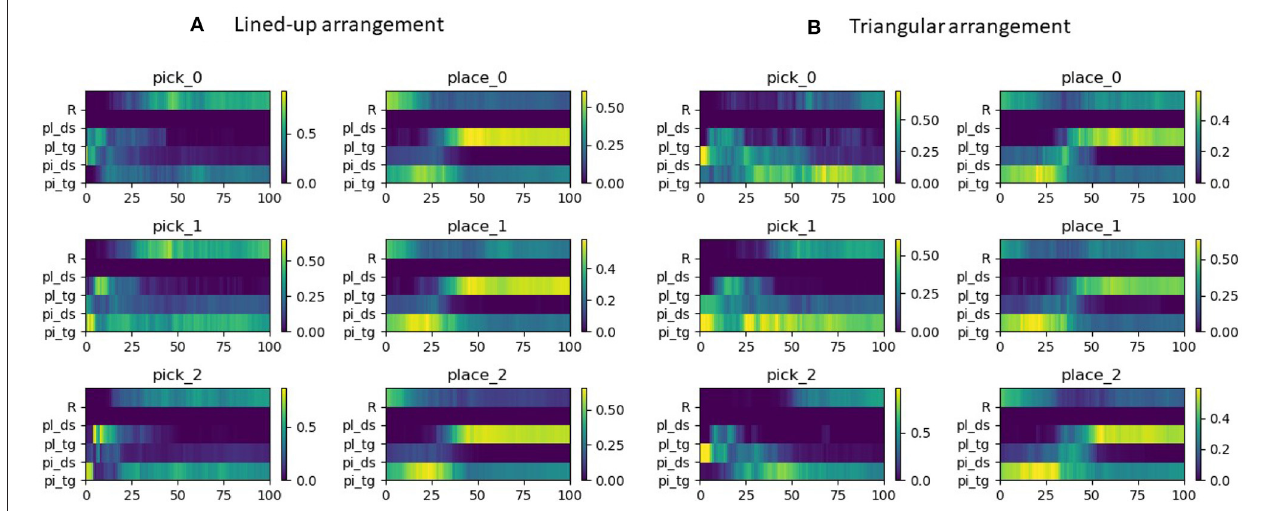
FIGURE 6 | Gaze distribution on a normalized time axis across semantic AoIs. Time = 0 signifies starting of the trial and time = 100 the closing of the gripper on the object for the pick sequences. This last event represents the start of the normalized time axis for the place sequences, with 100 indicating the end of the trial. (A) Lined-up arrangement. (B) Triangular arrangement.